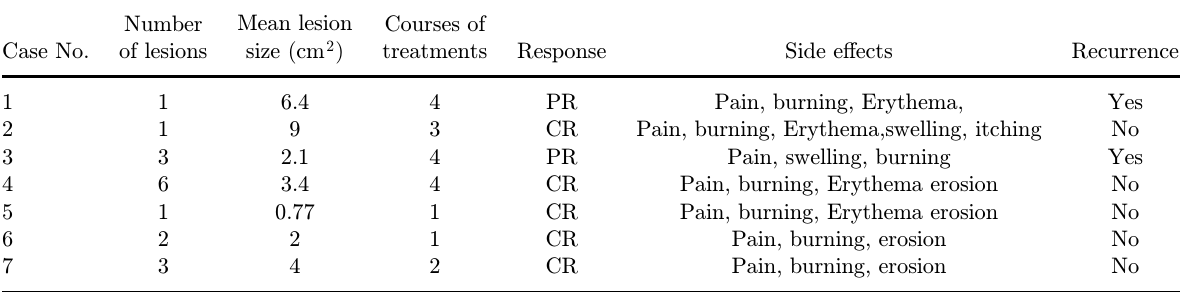
Table 2. Treatment